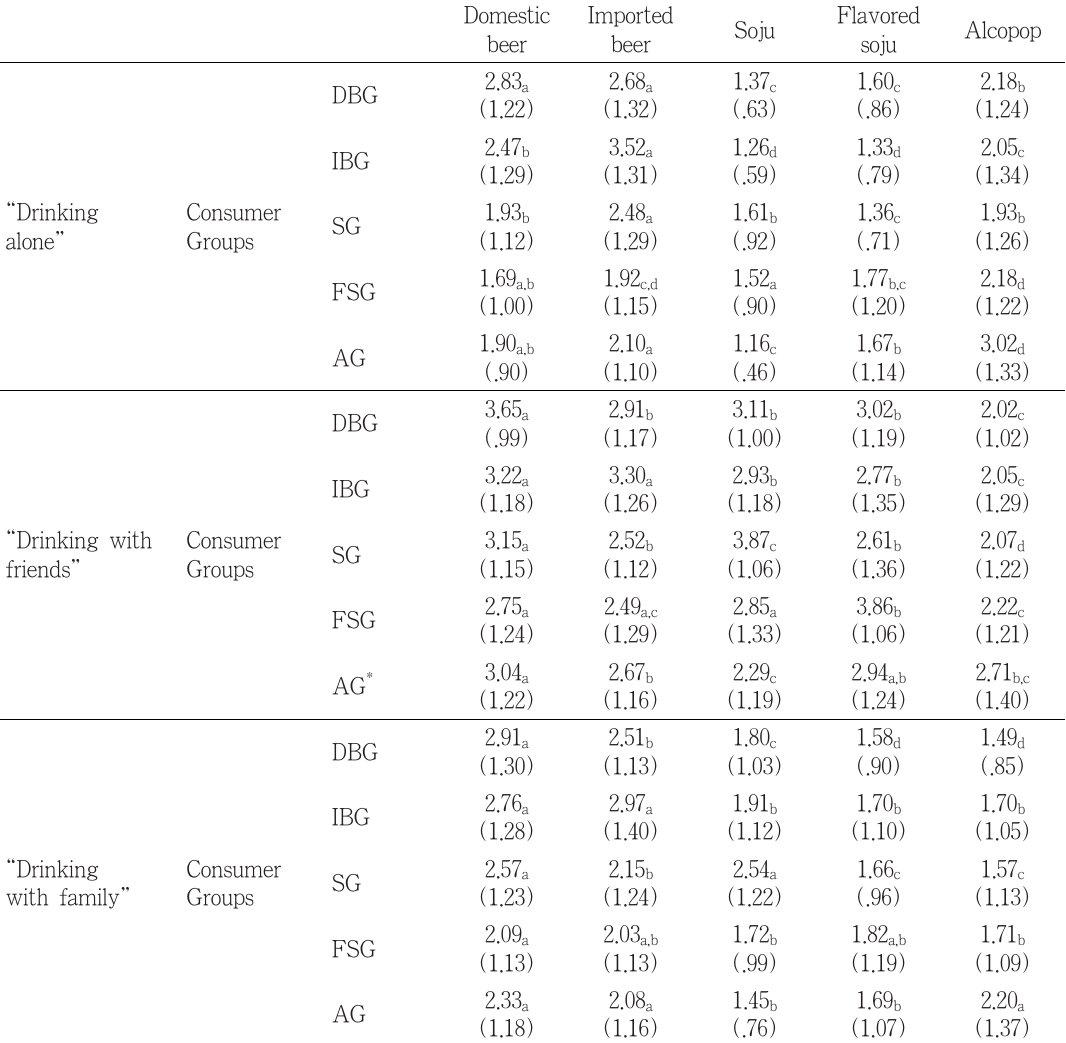
<Table 6> Each consumer group’s means and standard deviations of alcohol consumption frequency